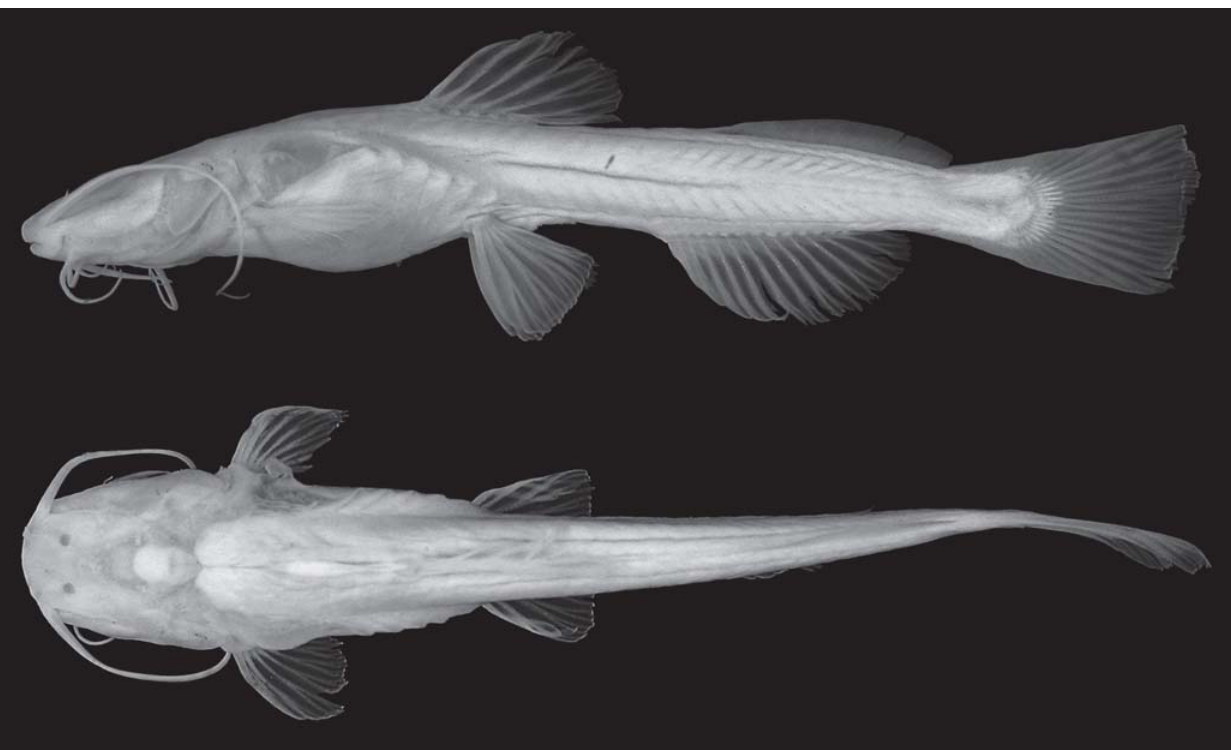
Fig. 1. Rhamdiopsis krugi , LIRP 5929, 37.1 mm SL, holotype; Poço Encantado cave, left margin of the rio Una, Municipality of Itaetê, State of Bahia, Brazil.